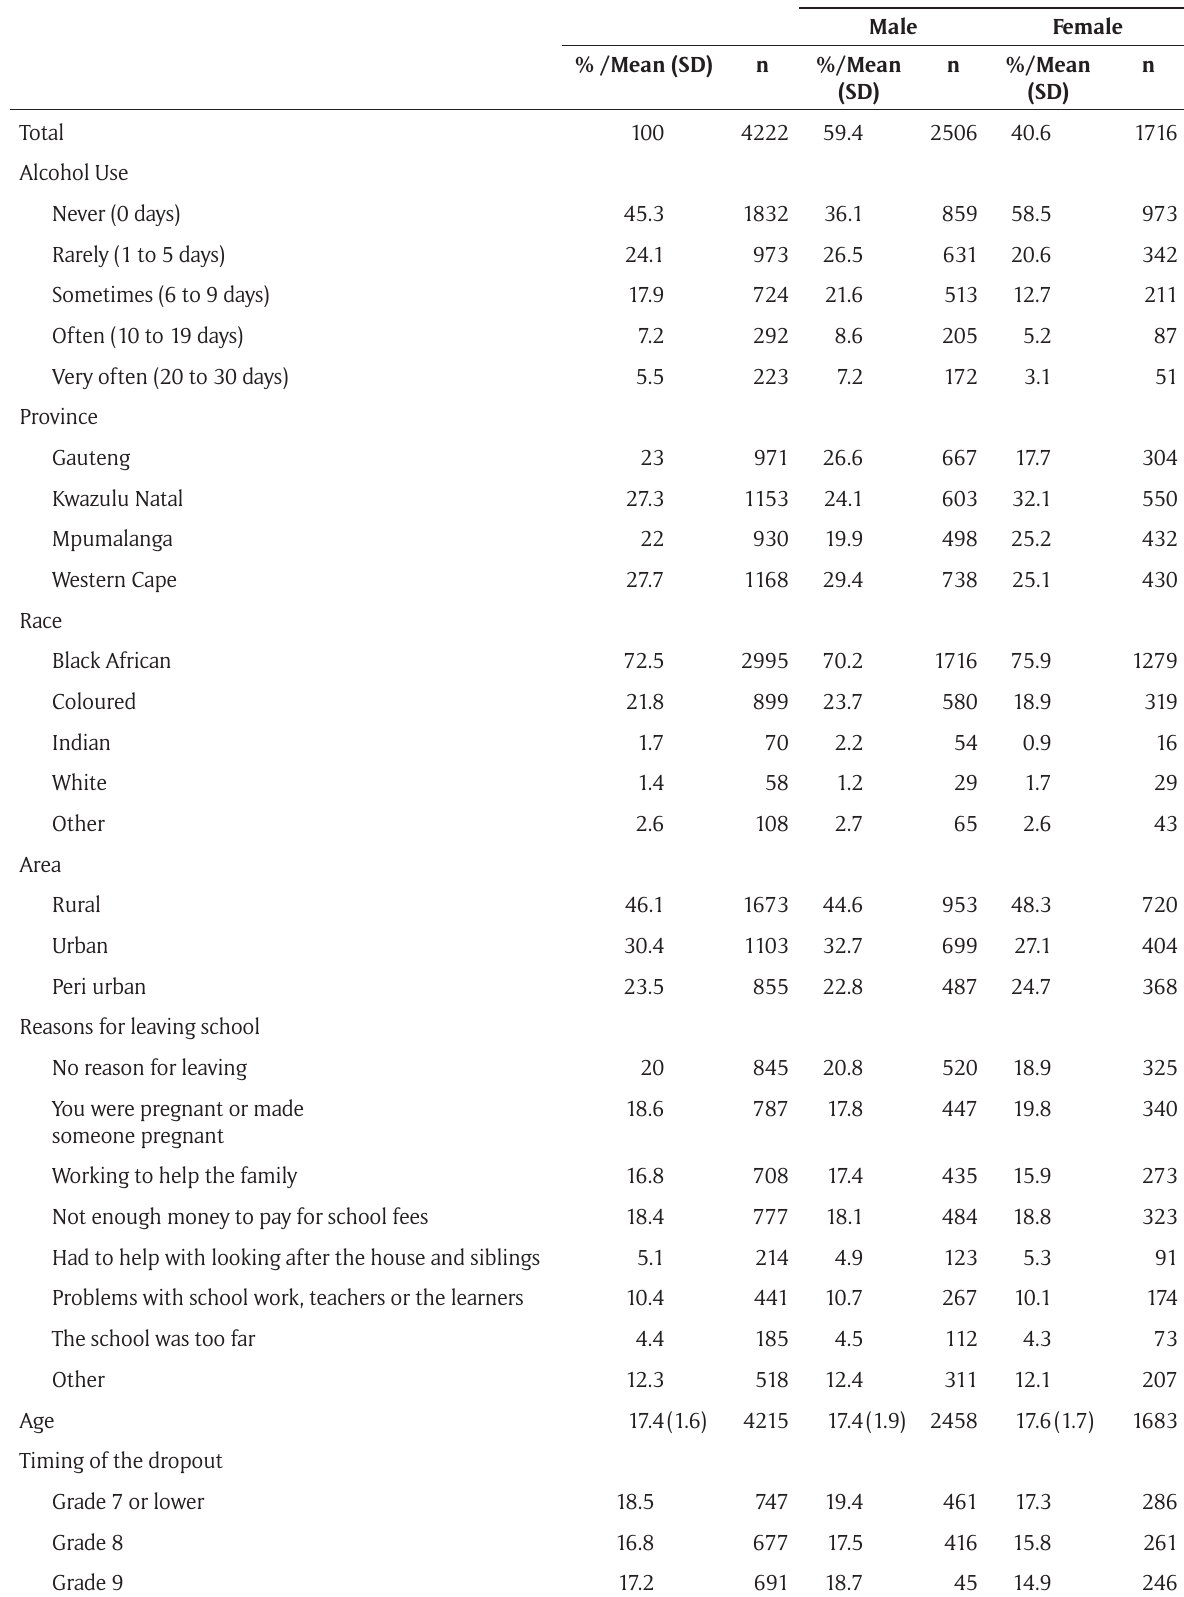
Table 1: Characteristics of the sample and reported reasons for leaving school per gender.